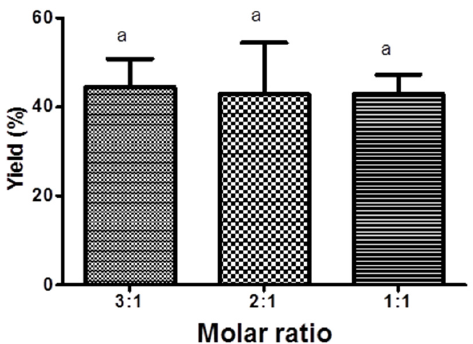
Figure 2. The effect of different molar ratio (palmitic acid:kojic acid) on 7- O -kojic acid monopalmitate synthesis in solvent-free system at 240 min using Novozyme 435 at 70 °C. Data are presented as means ± S.E.M, n = 3. The letter a indicates significant difference at p < 0.05 with Bonferroni’s Multiple Comparison Test.